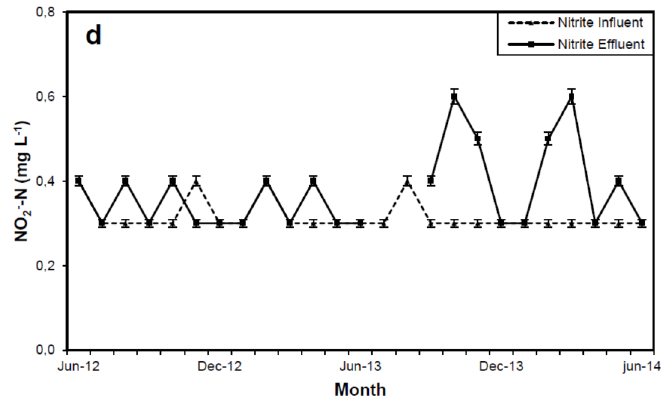
Figure 4. ( a ) Total nitrogen (TN), ( b ) Ammonium nitrogen (NH 4+ -N), ( c ) Nitrate nitrogen (NO 3 − -N) and ( d ) Nitrite nitrogen (NO 2 − -N) concentrations at the influent and the effluent of studied horizontal subsurface flow constructed wetland.